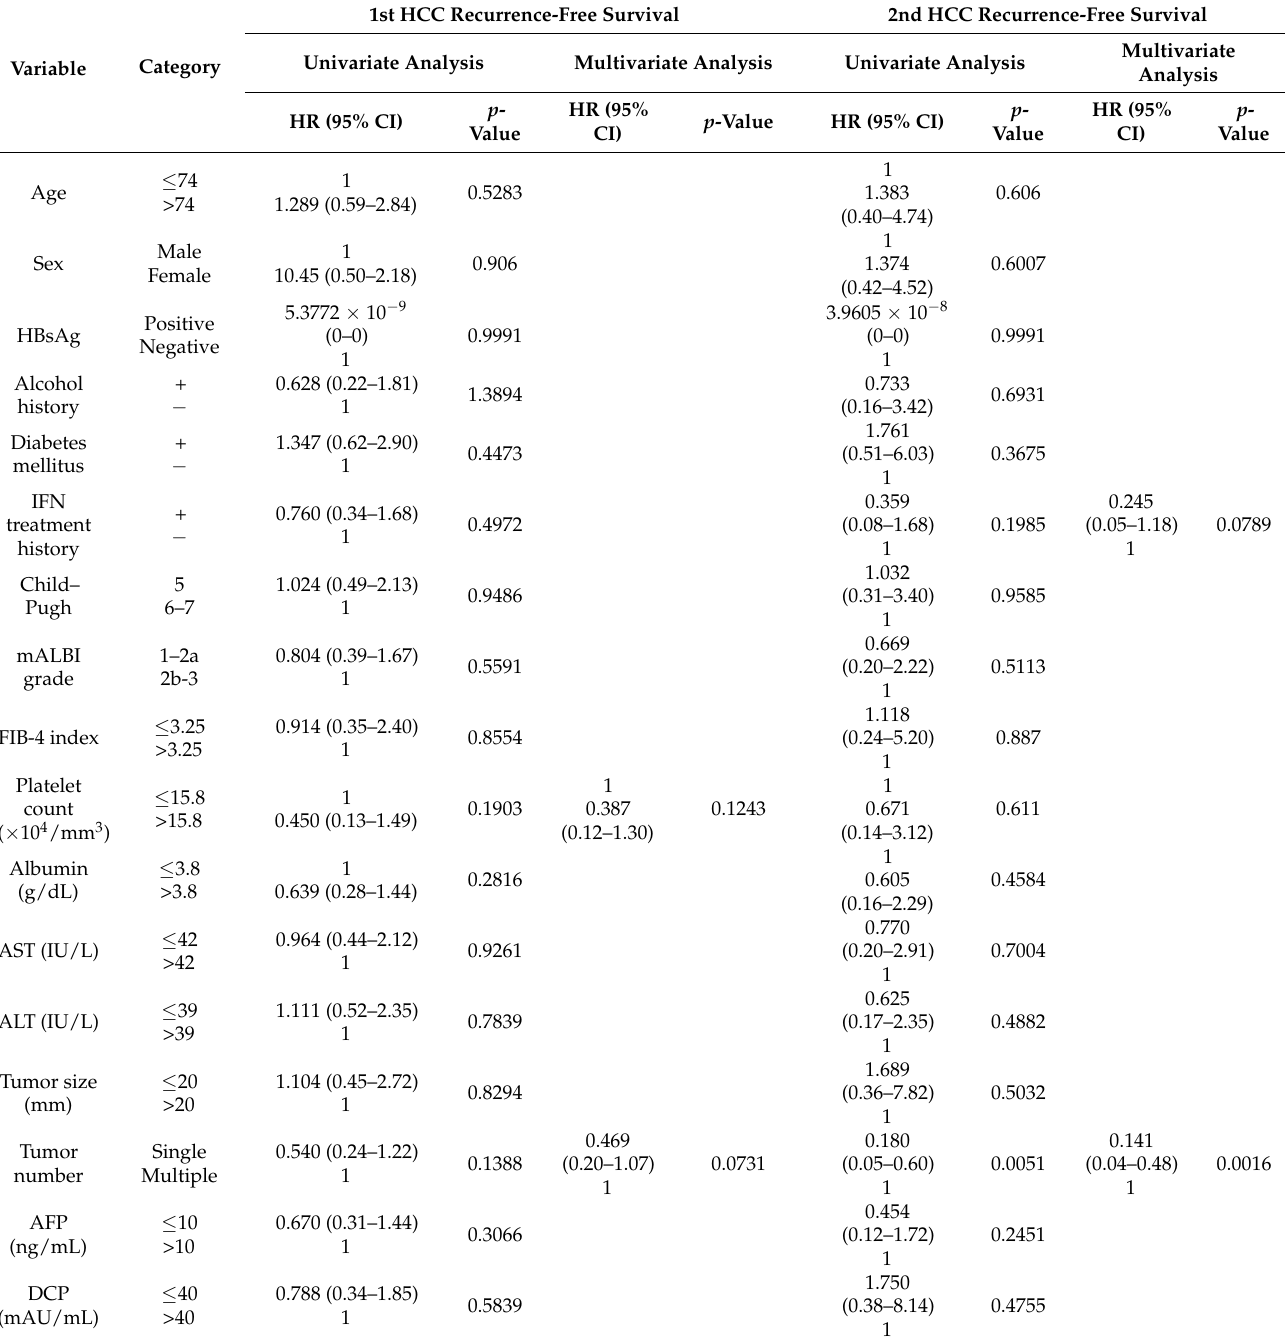
Table 5. Univariate and multivariate analyses of 1st and 2nd HCC recurrence-free survival in DAA-treated group after